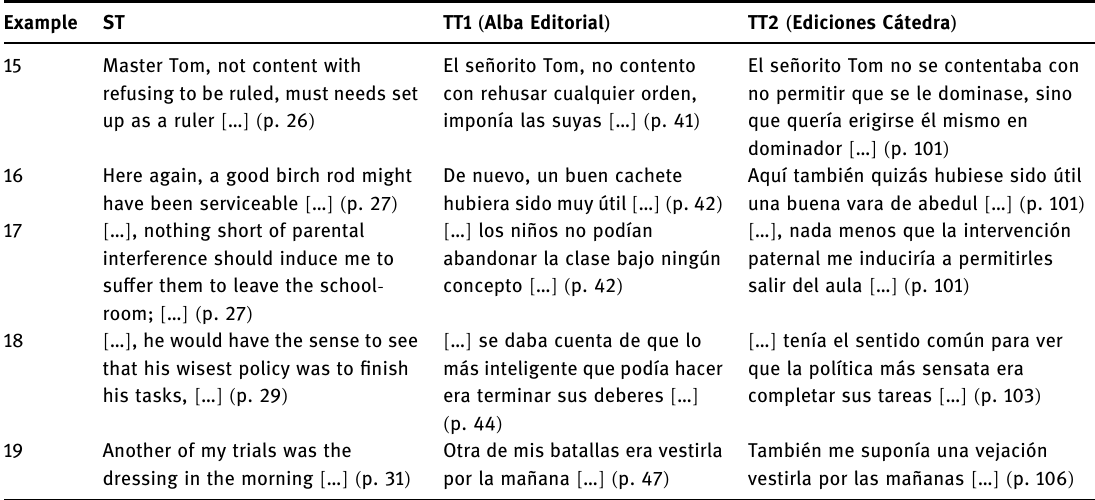
Table 3: Examples taken from Chapter 3 Example